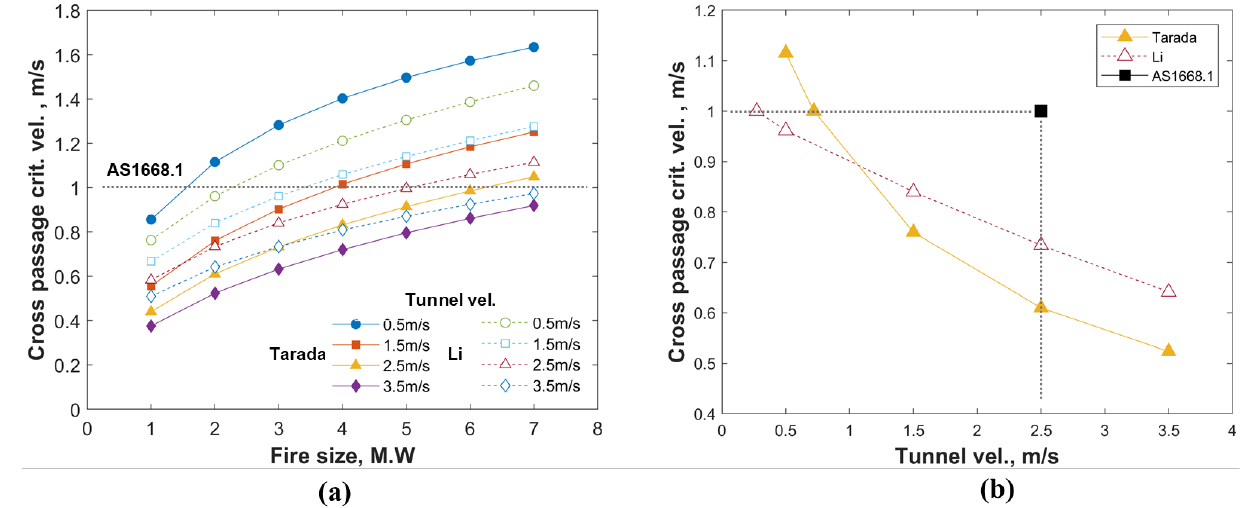
Figure 8. Comparison of cross-passage critical velocity requirements calculated using Li et al. [19] and Tarada [18]. ( a ) shows the distribution of cross-passage critical velocity at different fire sizes and tunnel velocities and ( b ) shows the cross-passage critical velocity vs. tunnel velocity specifically for a 2 MW fire.